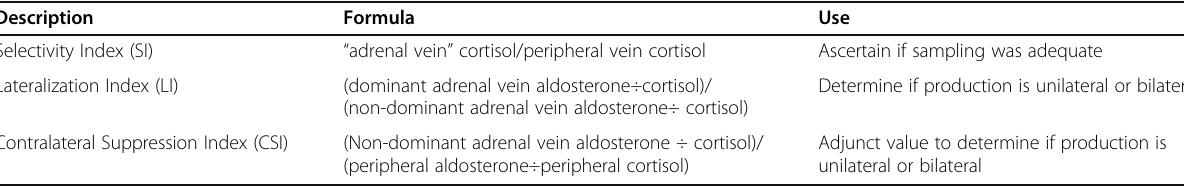
Table 6 Commonly used formulas in adrenal vein